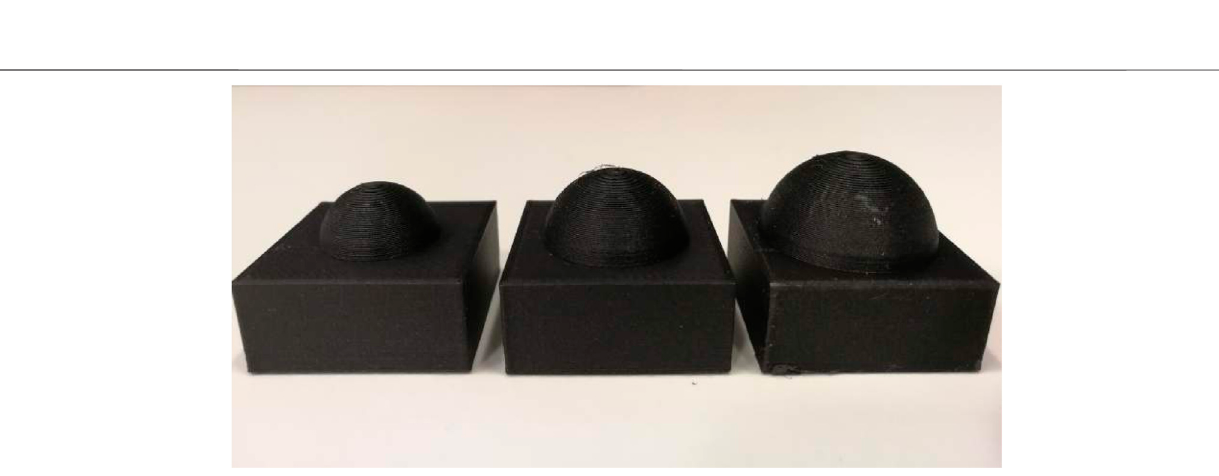
FIGURE 18 | The three spherical fi ngertips used for the sensitivity experiment. Each tip was printed twice and mounted on the gripper. From left to right: r f (cid:1) 0 . 008 , 0 . 01 , 0 . 012 m